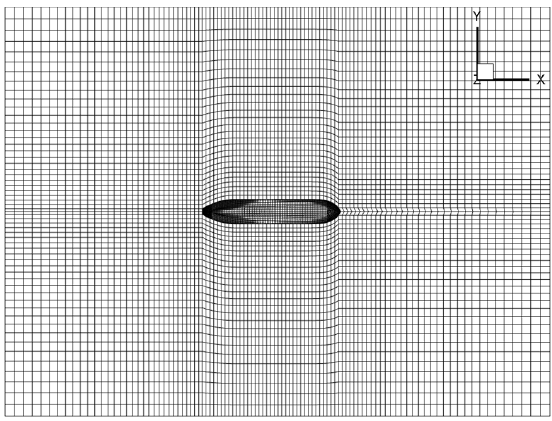
Figure 5. Grid diagram of the free surface.